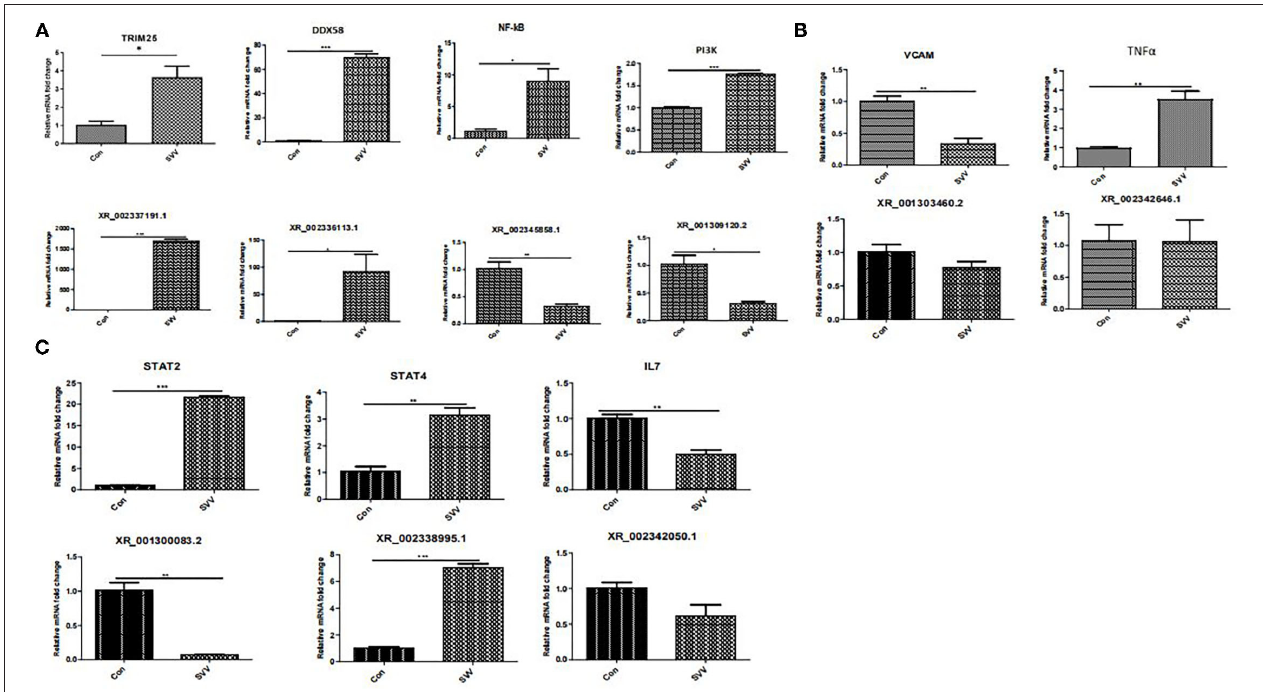
FIGURE 6 | RT–qPCR confirmation of new lncRNAs and target genes in PK15 cells in response to SVV. (A) NF-kappa B signaling pathway. (B) TNF signaling pathway. (C) JAK-STAT signaling pathway. *Stands for significant difference, **stands for more significant difference, ***stands for most significant